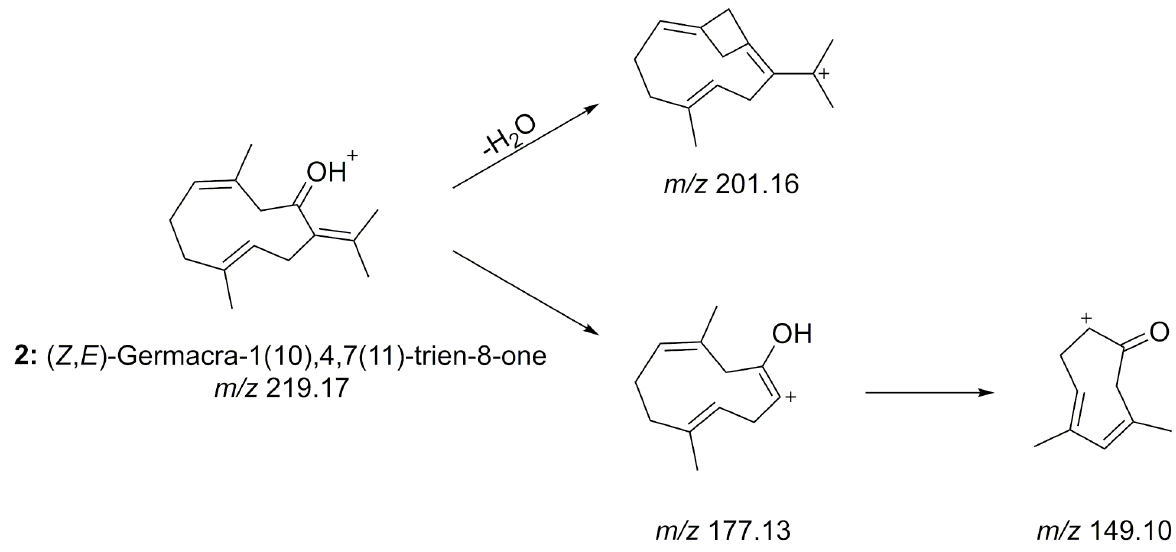
Figure 3. Proposed fragmentation pathways of ( Z , E )-germacra-1(10),4,7(11)-trien-8-one